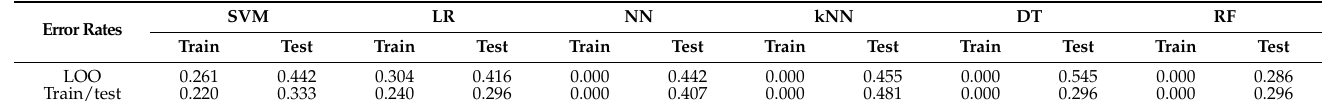
Table 3. Error rates for the original data set with selected features ( OrigD ∗